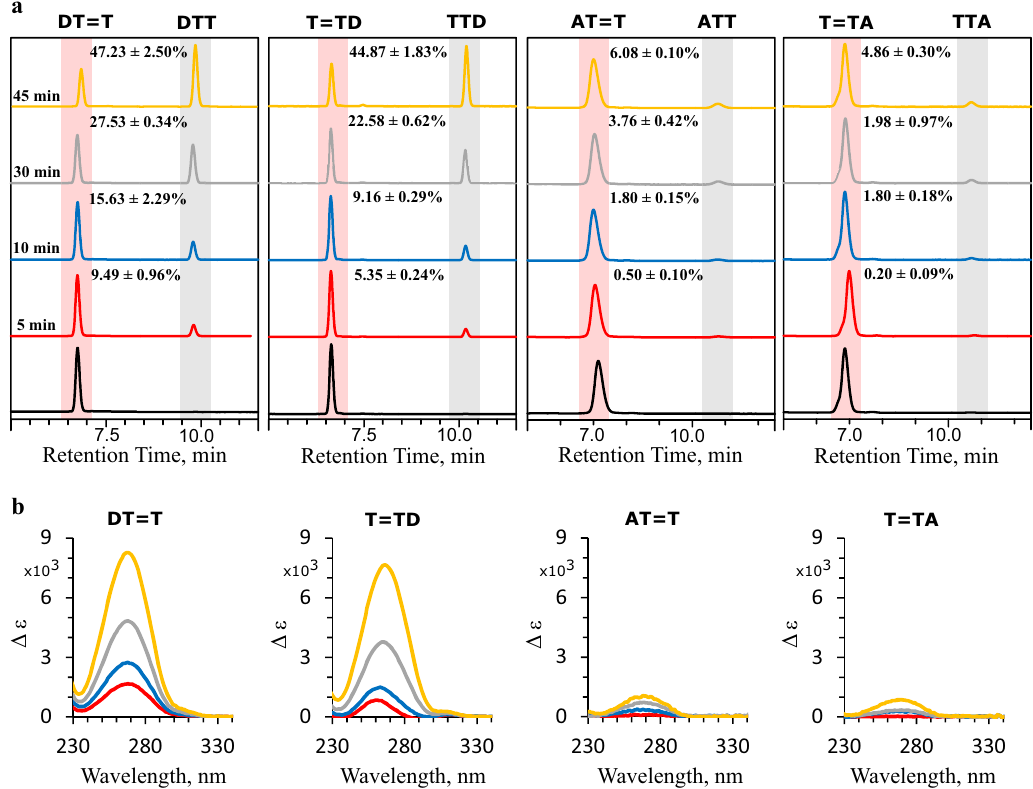
Fig. 2 UV-irradiation experiments ( λ exc = 280 nm, 80 µ W cm − 2 ) of damaged DNA trinucleotides containing a T = T dimer and A or D. a Analytical HPLC analysis of irradiated DT = T, T = TD, AT = T, and T = TA performed after different irradiation times. The peaks at shorter retention times correspond to damaged trinucleotides, while the peaks at longer retentions correspond to the repaired photoproducts. b Differential absorption UV spectra demonstrating changes of the spectrum of the irradiated material at different irradiation times. Both trinucleotides containing D exhibit signi fi cant increase of absorption at 264 nm, which corresponds to the absorption maximum of repaired T chromophore. Only minor increase of absorption at 264 nm can be observed for the trinucleotides containing